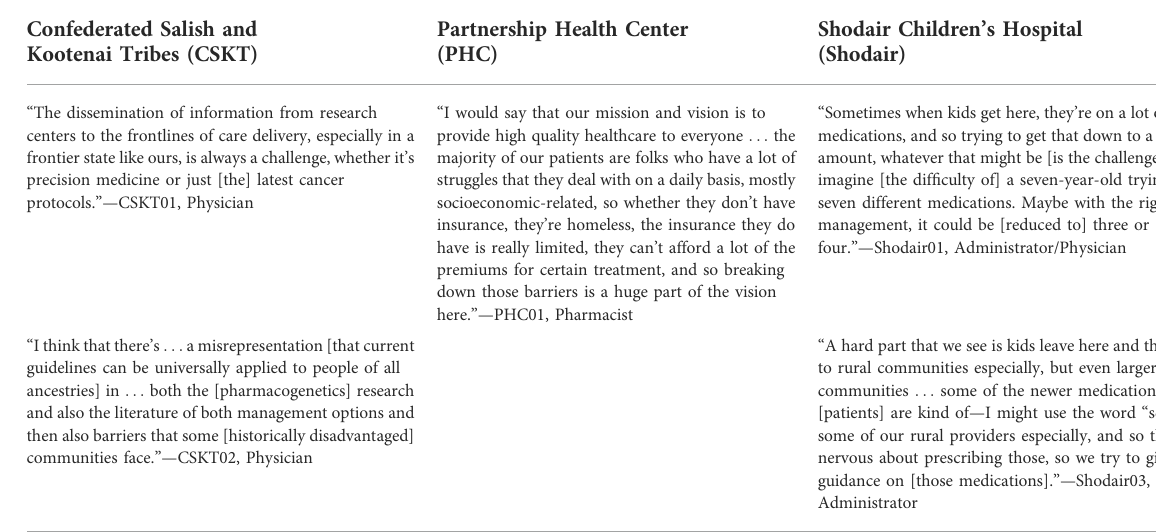
TABLE 3 Opportunities to mitigate medication management concerns unique to neglected